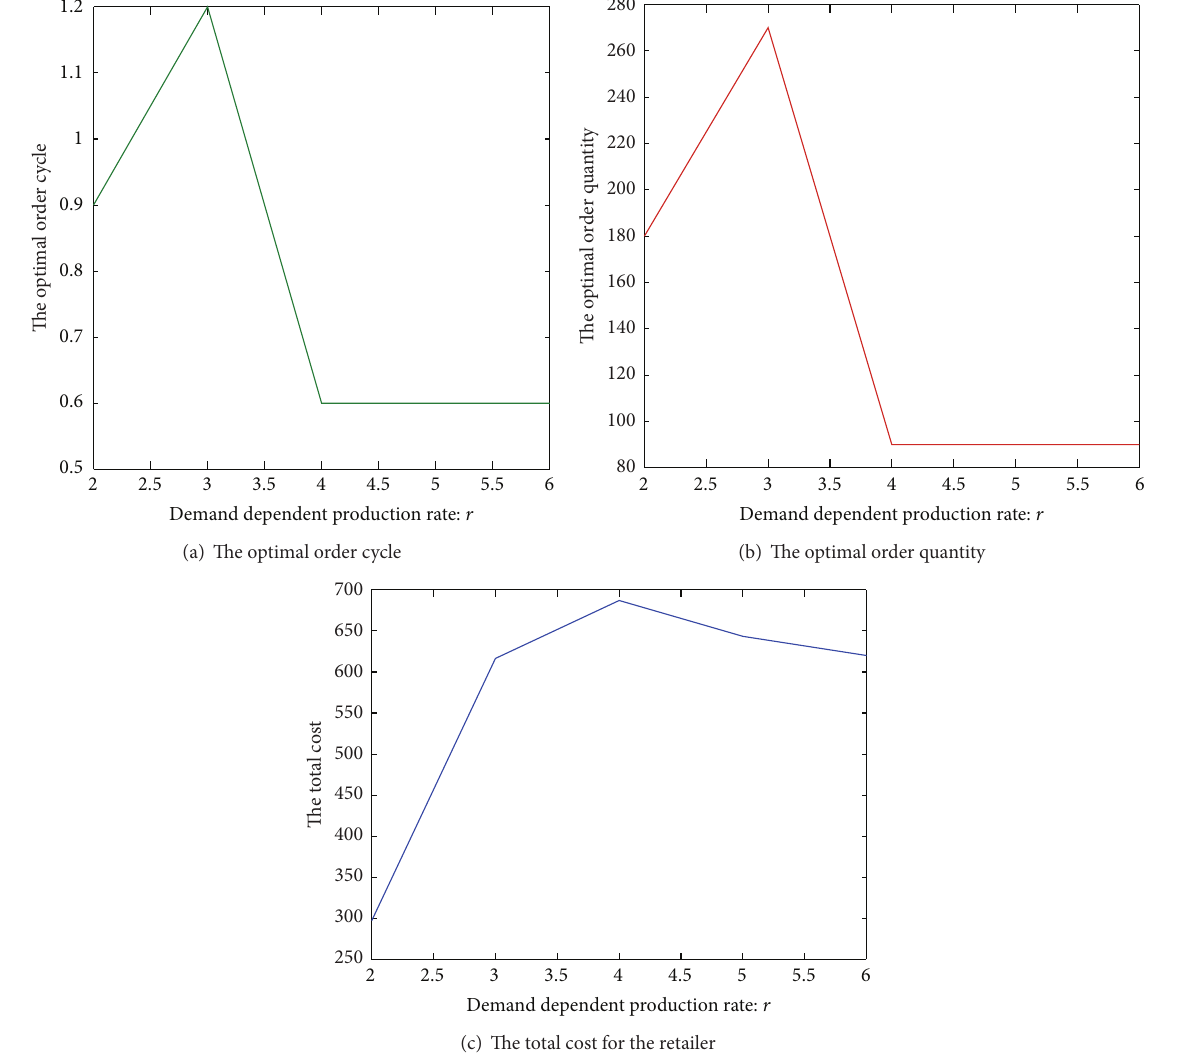
Figure 6: The impact of the changes of the parameter 𝑟 when 𝑀 ≤ 𝜇